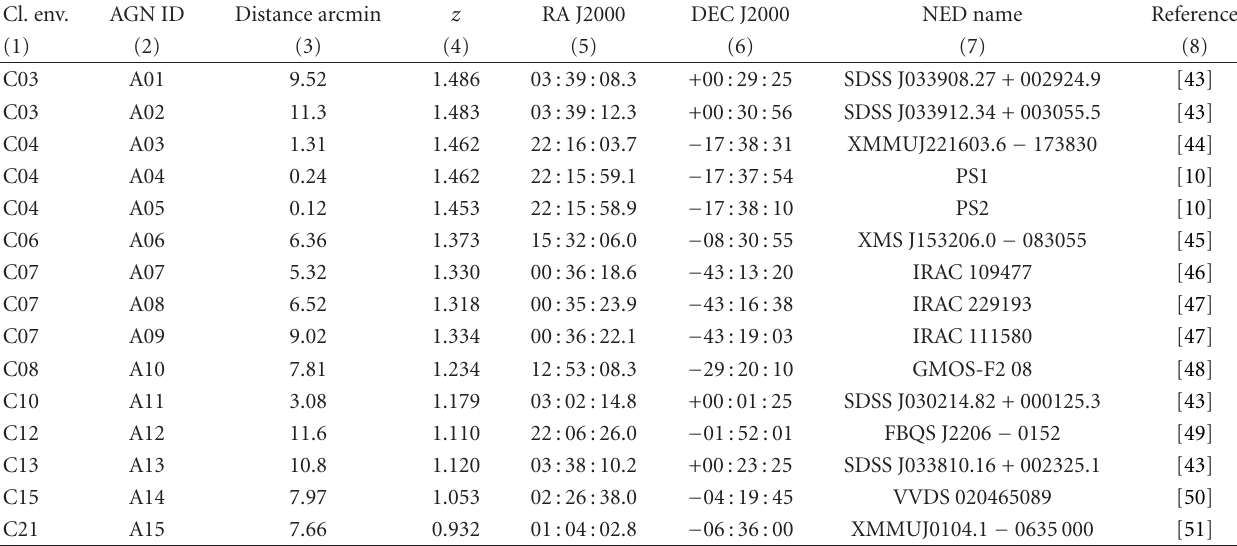
Table 2: List of spectroscopically confirmed X-ray AGN within a search radius of 12 (cid:3) ( (cid:5) 6 Mpc) from the cluster centers and with a spectroscopic redshift that is within ± 3000 km/s of the cluster restframe velocity. The table lists the cluster environment ID of Table 1 in column (1), an AGN ID in (2), the angular distance to the cluster center in (3), the AGN redshift in (4), the RA and DEC coordinates in (5-6), the source name as listed in NED in (7), and a redshift reference in (8). Cl.